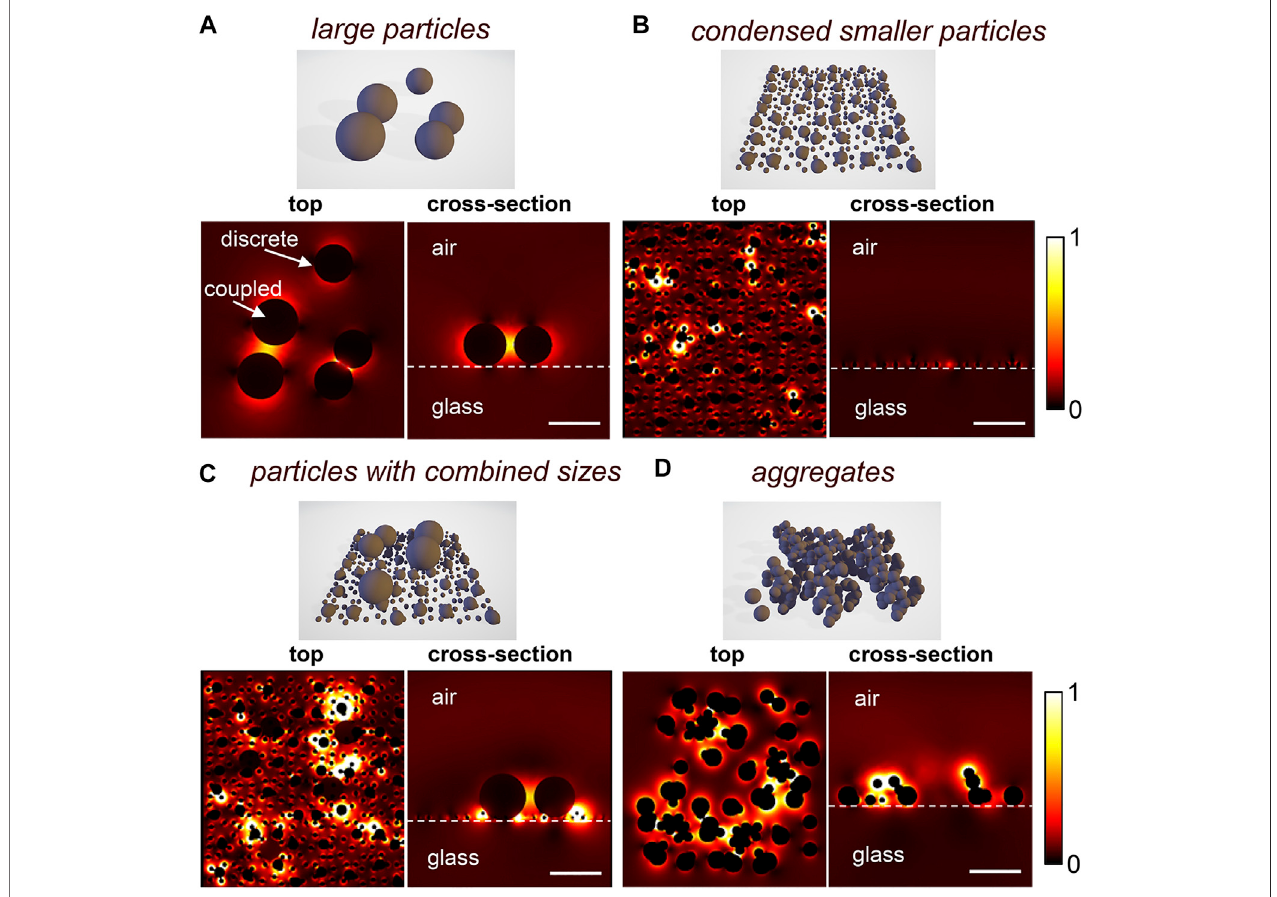
FIGURE 6 | Electromagnetic fi eld distributions for wavelength 633 nm for (A) large AgNPs (80 and 100 nm), (B) condensed small particles (10 nm) with some moderate particles (30 nm), (C) combination of condensed small particles (10 nm), moderate particles (30 nm), and large AgNPs (80 and 100 nm). (D) AgNP aggregations. The scale bars indices are 100 nm.